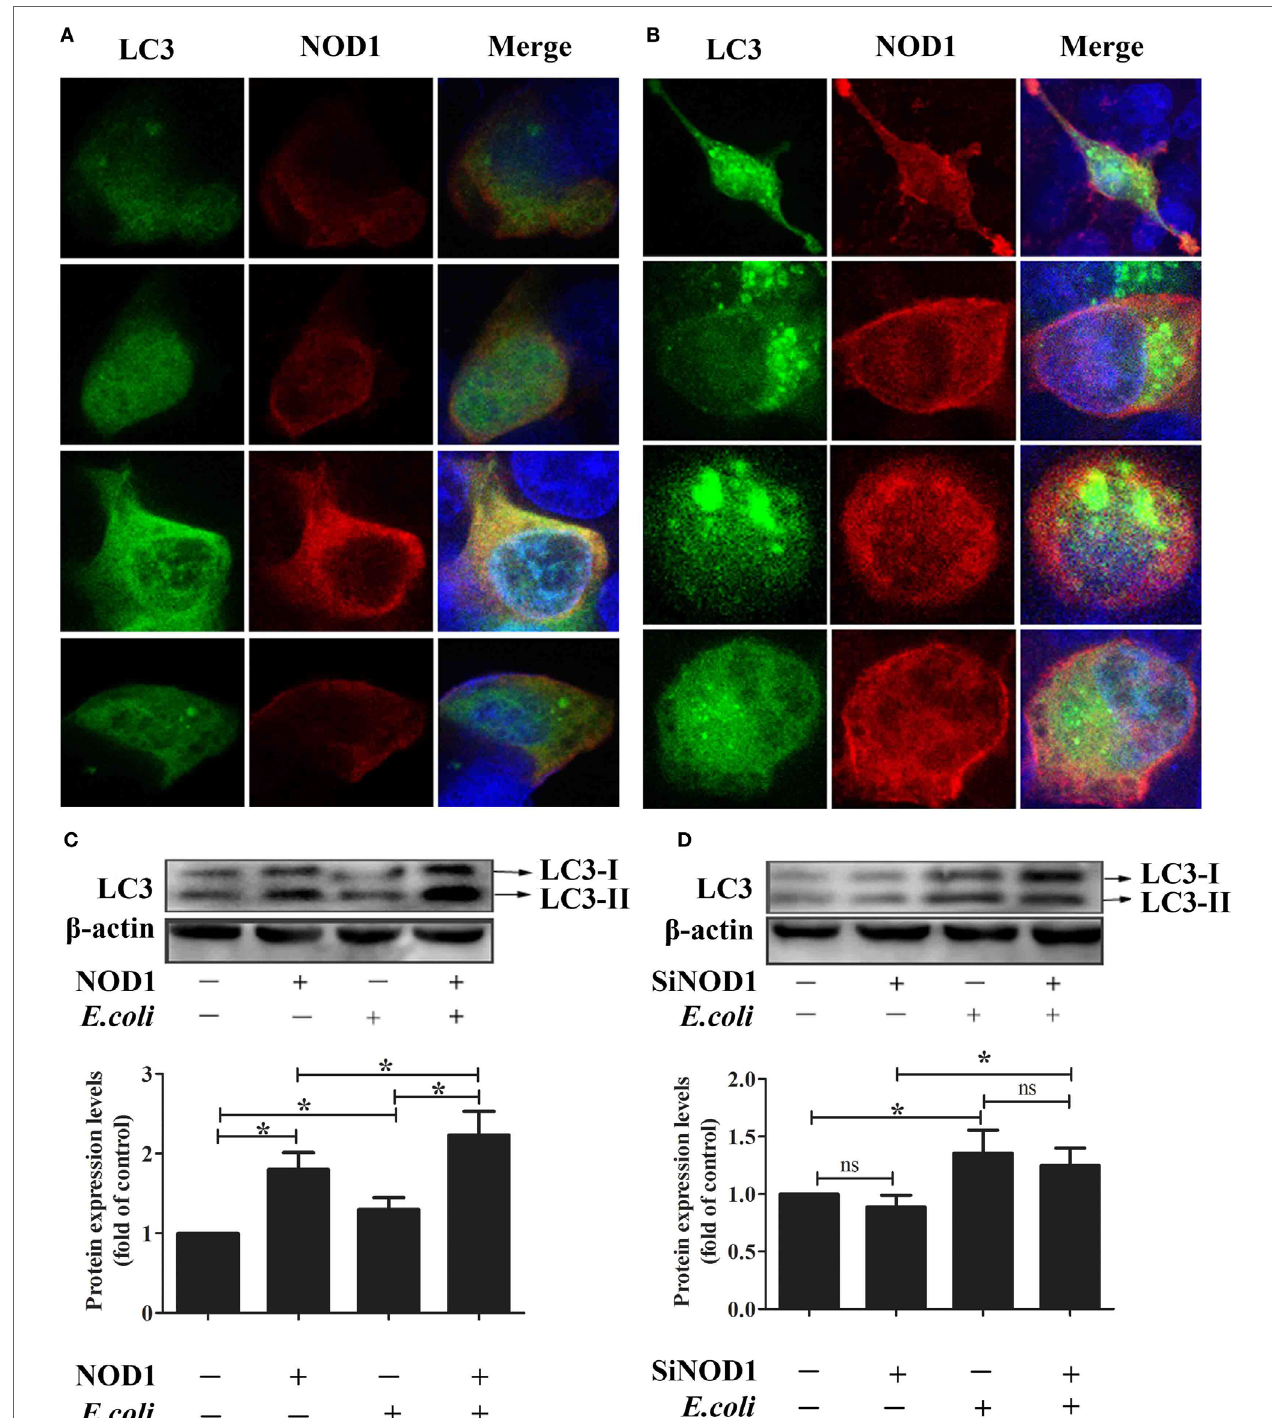
FigUre 9 | Rabbit nucleotide-binding oligomerization domain 1 (rNOD1) induces autophagosome formation in RK-13 cells. (a) Immunofluorescent imaging of RK-13 cells cotransfected with pC-rNOD1 and GFP-LC3 plasmids. rNOD1 appears in red, LC3 in green, and DAPI in blue. (B) Immunofluorescent imaging of RK-13 cells cotransfected with pC-rNOD1 and GFP-LC3 plasmids and infected with E. coli . rNOD1 appears in red, LC3 in green, and DAPI in blue. Immunoblot analysis of RK-13 cells transfected with (c) pC-rNOD1 or (D) si-rNOD1, followed by infection with E. coli . Data are expressed as the ratio of protein band intensity in treated cells to that of the corresponding protein in control cells. LC3-II expression was normalized to β -actin expression. M ± SD from three independent experiments are presented. Significant differences are indicated by